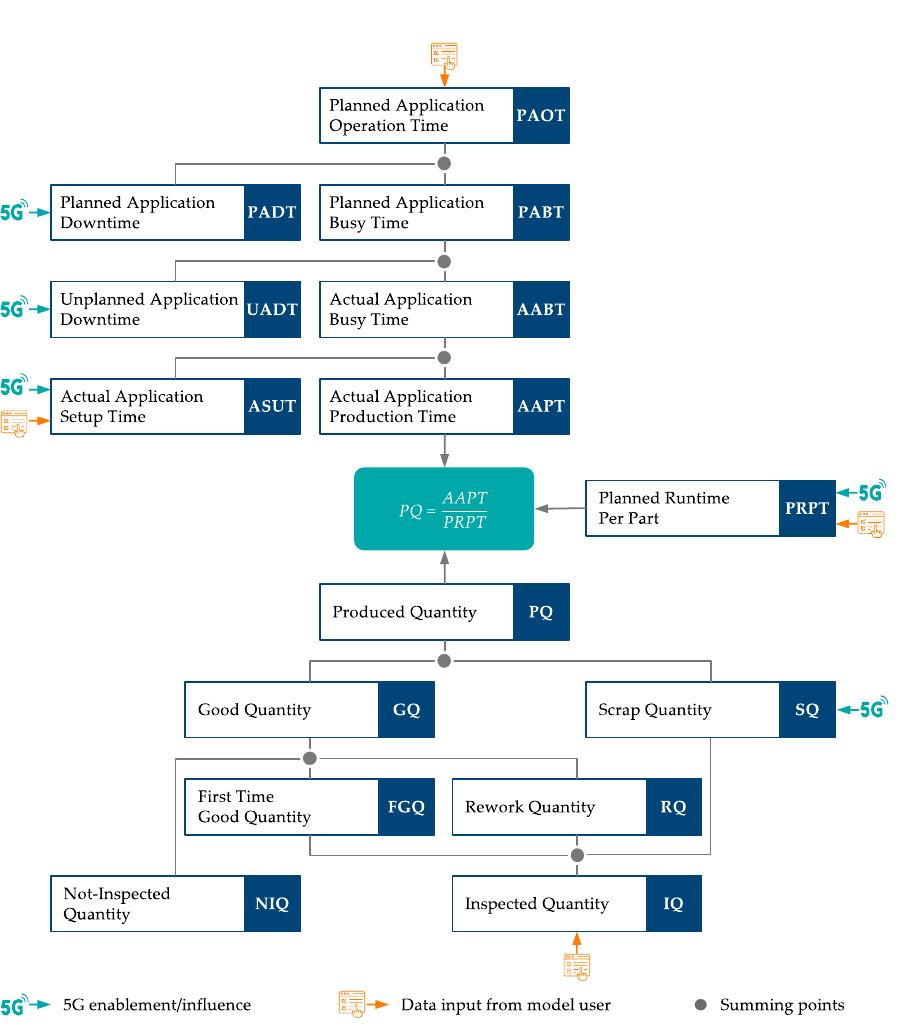
Figure A1. Core elements of mathematical model and their relation.